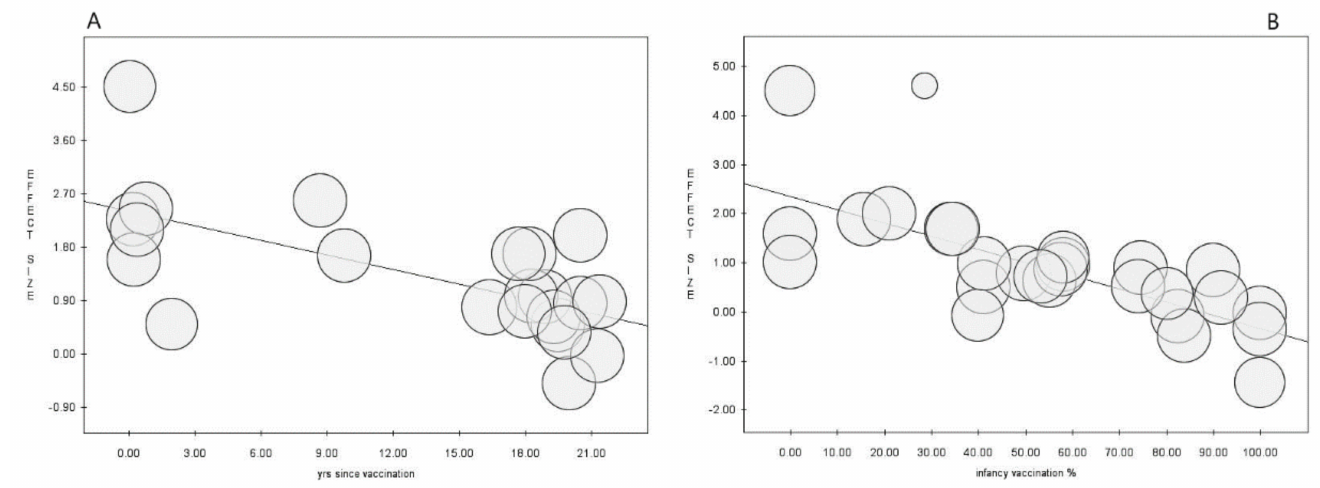
Figure 5. Meta-regression analysis for time (in years) since primary cycle vaccination ( A ) and proportion of vaccination during infancy ( B ), showing negative associations with the proportion of seroprotected individuals.